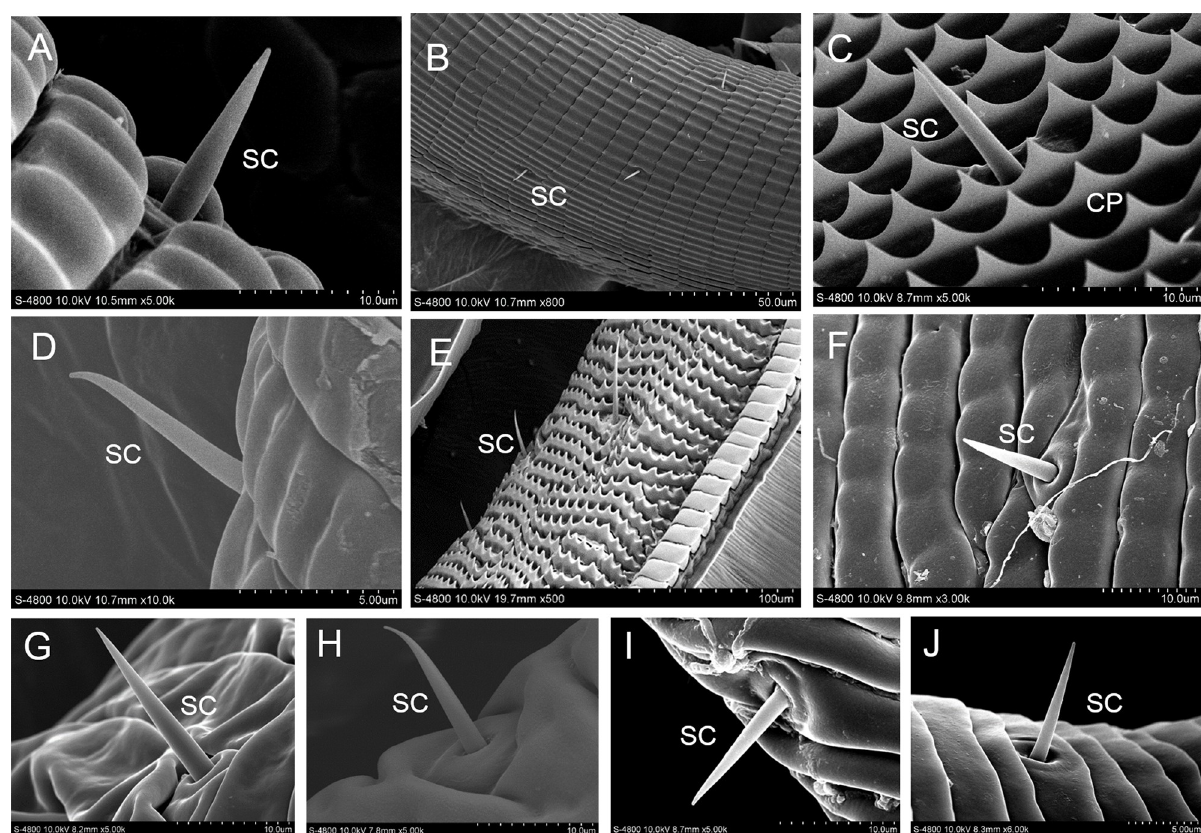
Fig 2. Sensilla chaetica (SC). A: I . podalirius ; B: P . guttata ; C: Co . fieldii ; D: Ce . oreas ; E: Sa . charonda ; F: T . limniace ; G: A . issoria ; H: St . neumogeni ; I: Ca . suroia ; J: L . celtis